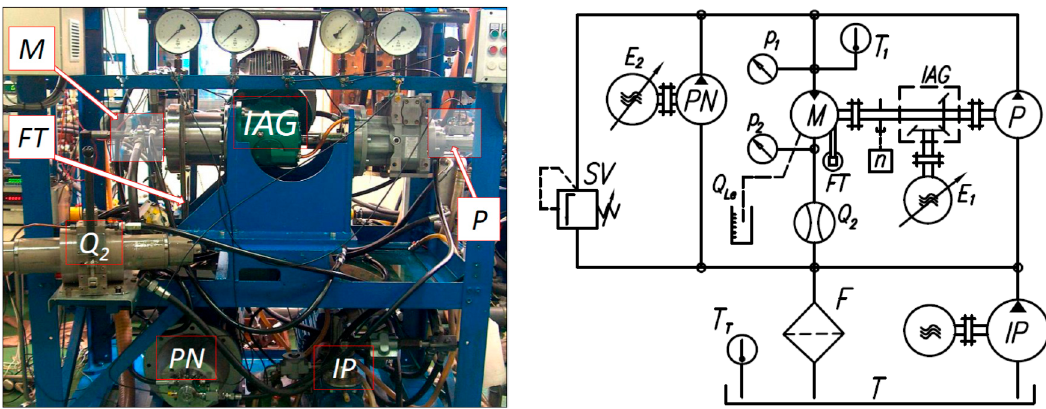
Figure 8. Diagram of the test stand measurement system [21]: P —pump, M —tested hydraulic motor, PN —pump for filling leaks in P and M , IP —impeller pump (pre-supply pomp), SV —safety valve, F —